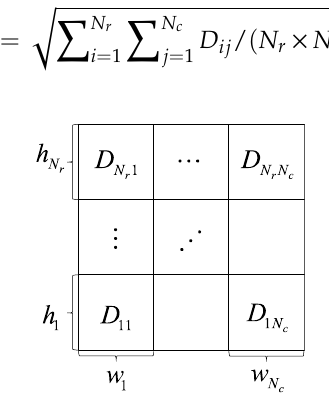
Figure 1. Original table.